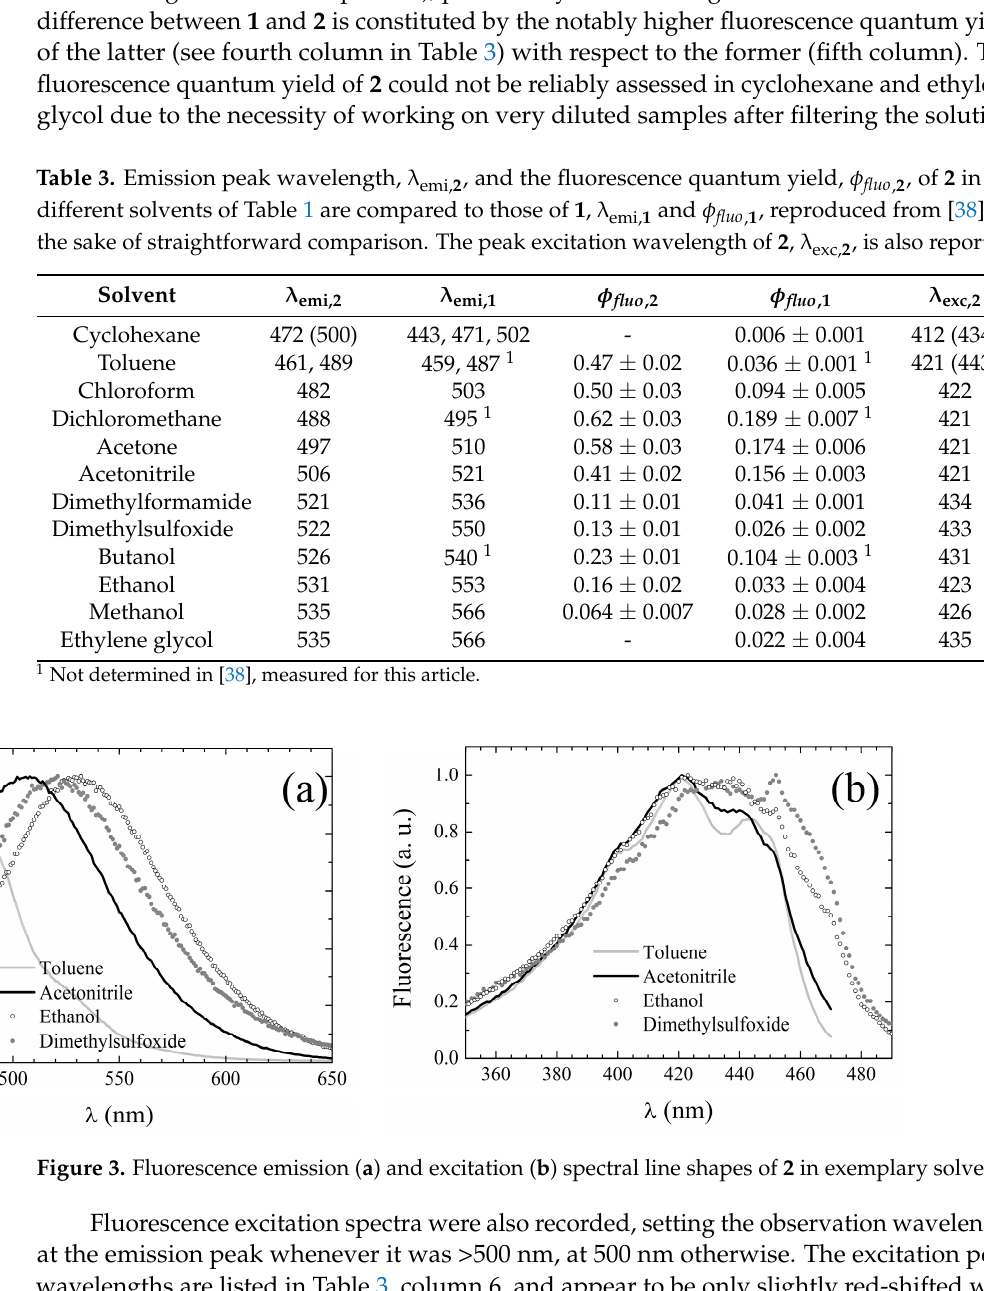
Table 4. Decay times, τ i , and pertaining relative amplitudes resolved in the fluorescence decay